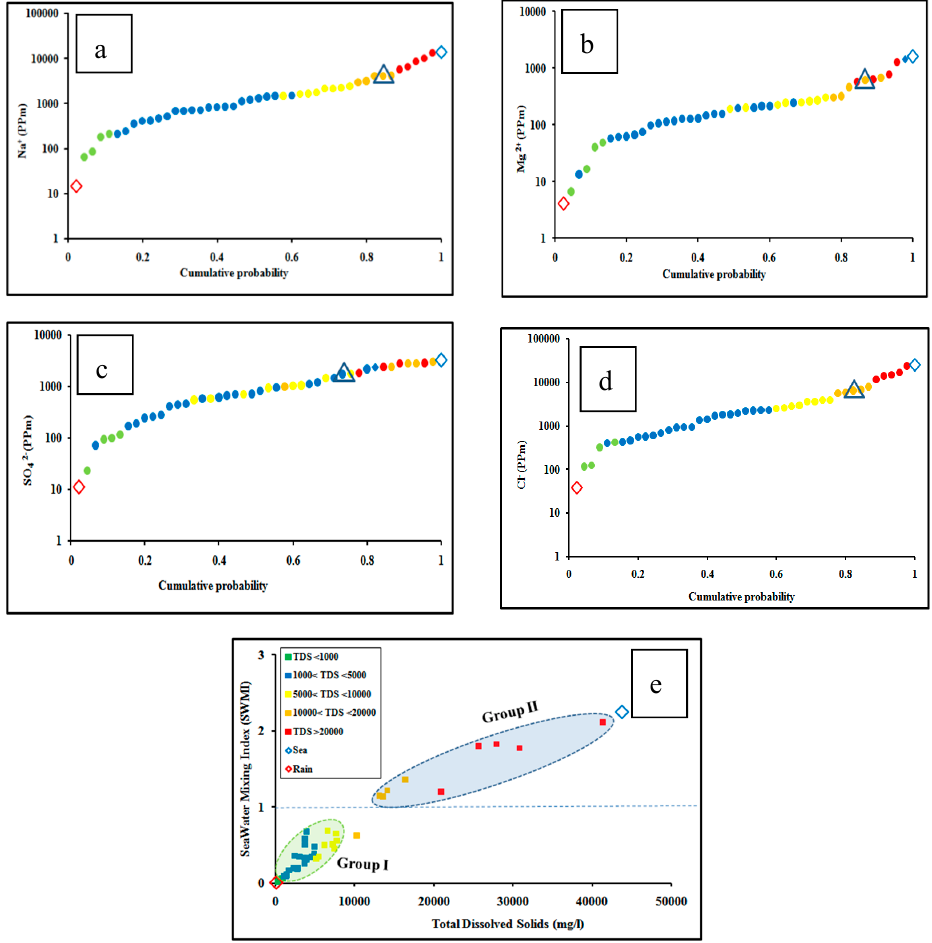
Figure 6. Cumulative probability curves for the distribution of ( a ) Na + , ( b ) Mg 2+ , ( c ) Cl − , ( d ) SO 4 2 − in groundwater samples), ( e ) Cross-plot of seawater mixing index vs. total dissolved solids of the studied groundwater samples. Black triangles refer to the inflection points.